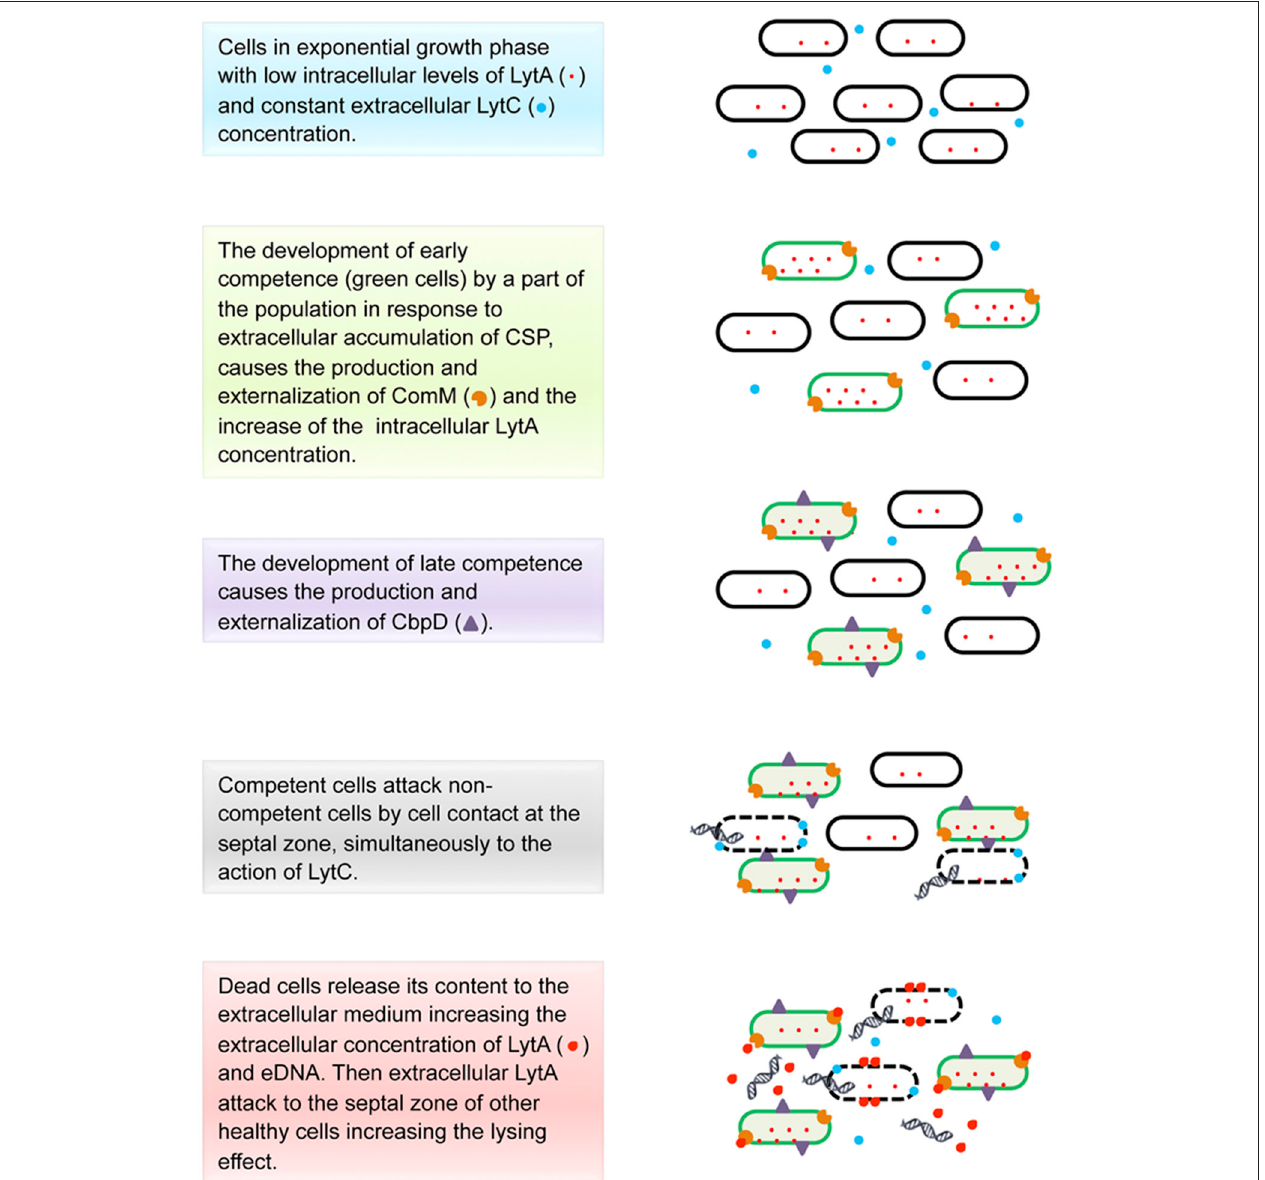
FIGURE 2 | Model for eDNA production in Streptococcus pneumoniae